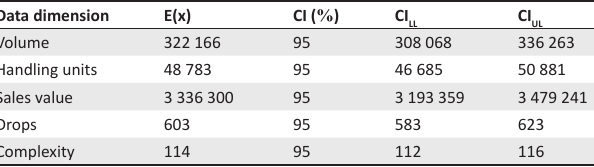
TABLE 5: Confidence intervals for the expected value of each